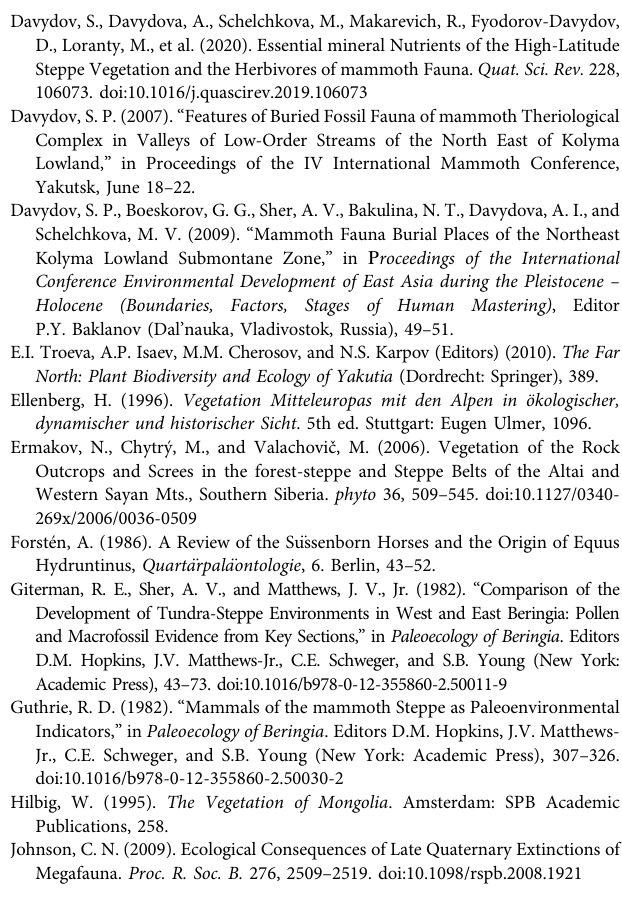
Table for the Last 2.7 Million Years, Version 2019 QI-500. Quat. Int. 500, 20 – 31.